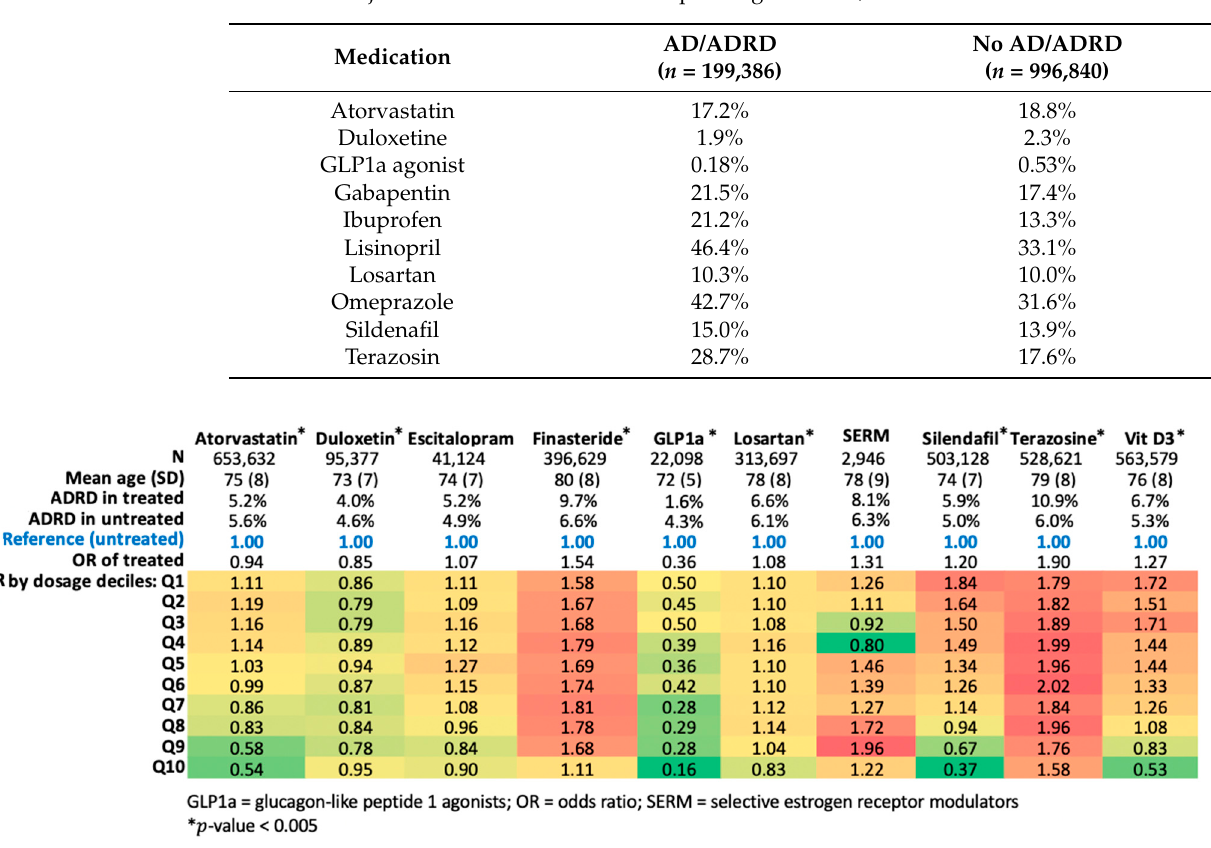
Table 1. Unadjusted association between sample drugs and AD/ADRD.